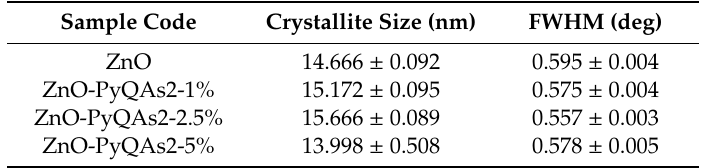
Table 2. Comparative values of average crystallite size and FWHM values for the ZnO samples obtained by the recipe utilizing the organic agent